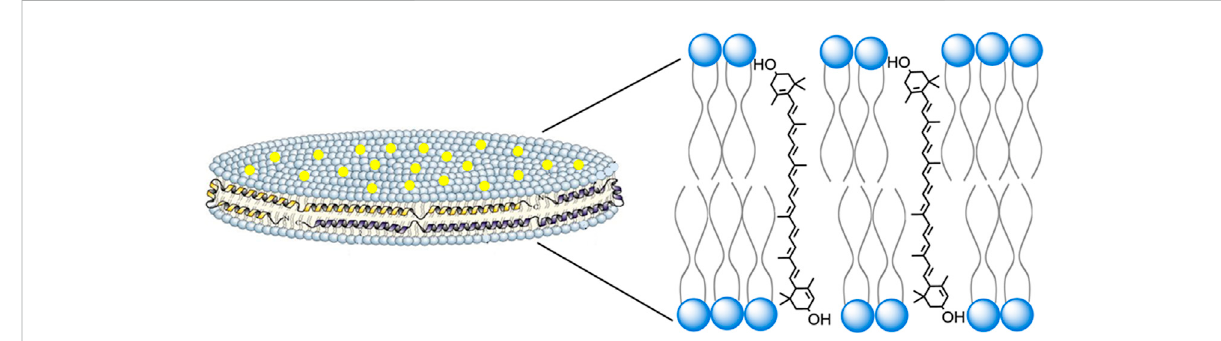
FIGURE 7 Structure and organization of lutein ND. A lutein ND particle is depicted showing a disk-shaped phospholipid bilayer with integrated lutein molecules(yellowdots).Thediskiscircumscribedbyapolipoproteinscaffoldmoleculeswhichcontactotherwisesolventexposedphospholipidfatty acyl chains at the edge of the bilayer. In the expanded view, a plausible spatial orientation of lutein, with respect to the phospholipid bilayer, is presented. In this depiction lutein aligns parallel to phospholipid fatty acyl chains, such that its two hydroxyl moieties remain solvated, each localizing near phospholipid polar head groups at the aqueous